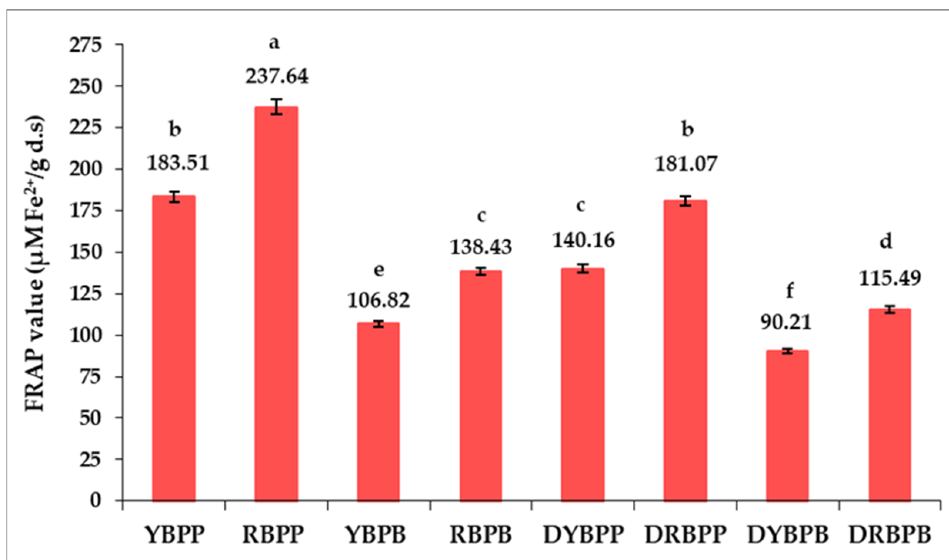
Figure 4. Ferric reducing antioxidant power of yellow and red bell pepper pulp and processing by- products, fresh and after drying. Results are expressed as the mean value of three determinations ± standard deviation (SD) indicated by the error bars. According to the t-test, different letters (a–g) represent significant differences ( p < 0.05) between the values represented in the columns.